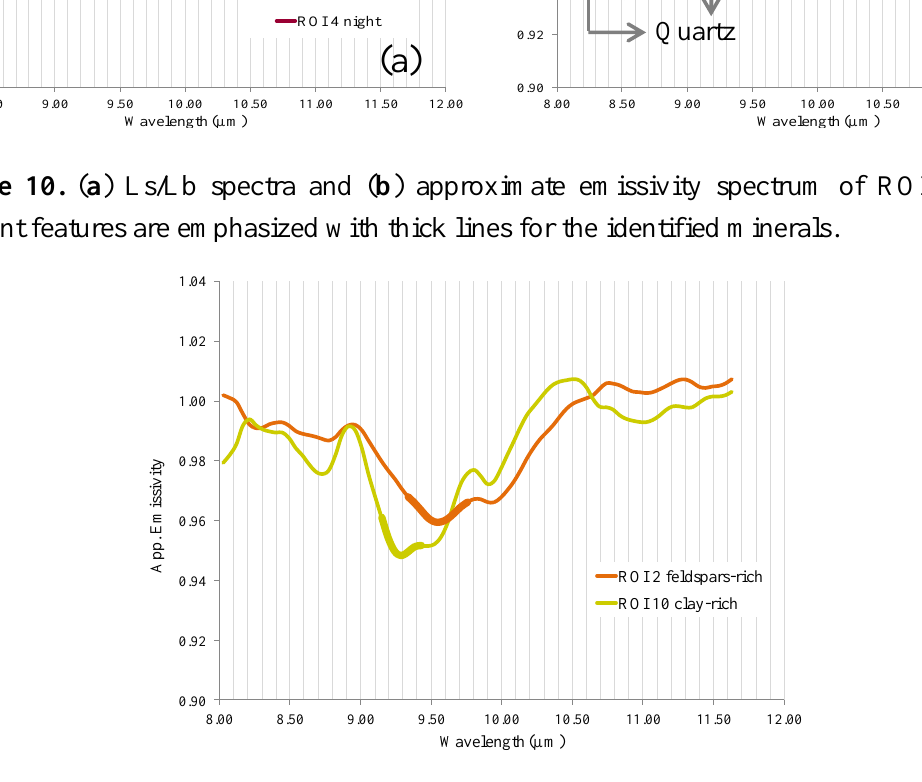
Figure 11. Approximate emissivity spectrum of two ROIs representing two types of silicates-rich rocks. The relevant features are emphasized with thick lines for the identified